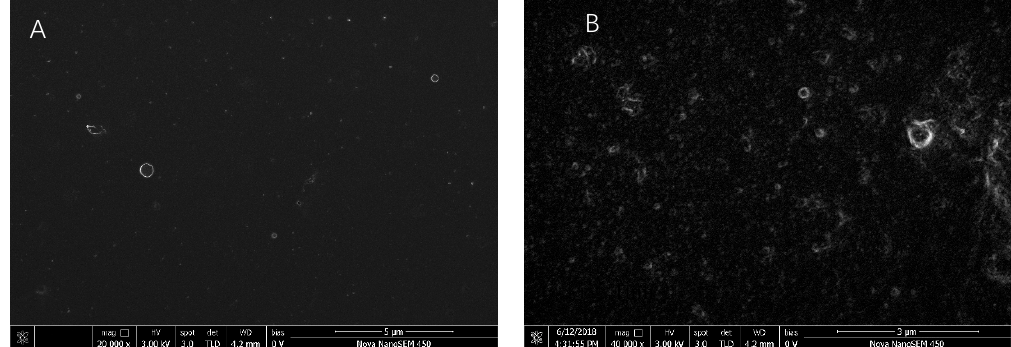
Figure 8. SEM images of LF NPs ( A ) and LF-CA NPs ( B ).